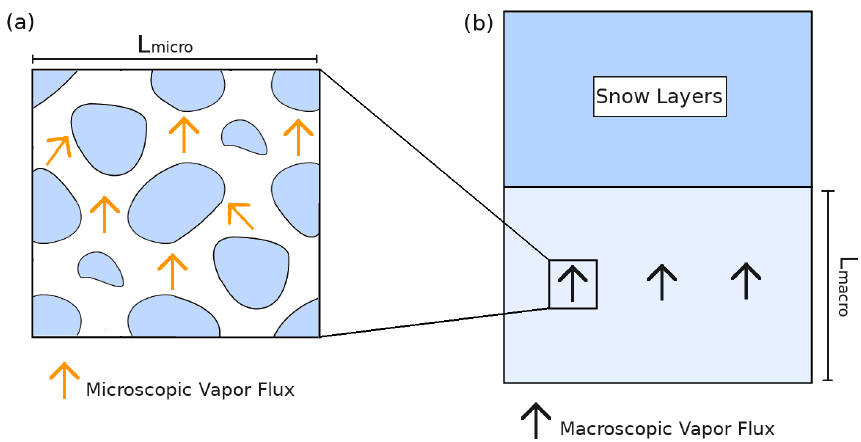
Figure 2. Relationship between the microscopic and macroscopic points of view of a snow sample. (a) Microscopic point of view with the ice in blue and microscopic vapor flux in orange. (b) Macroscopic point of view where the snowpack is seen as a layered